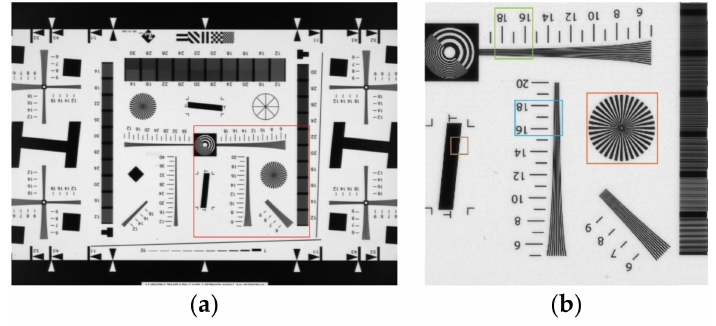
Figure 13. ( a ) The captured RRA image, frame 1. ( b ) The reconstructed image of our algorithm. The areas marked with the rectangles are zoomed and compared in Figure 14.